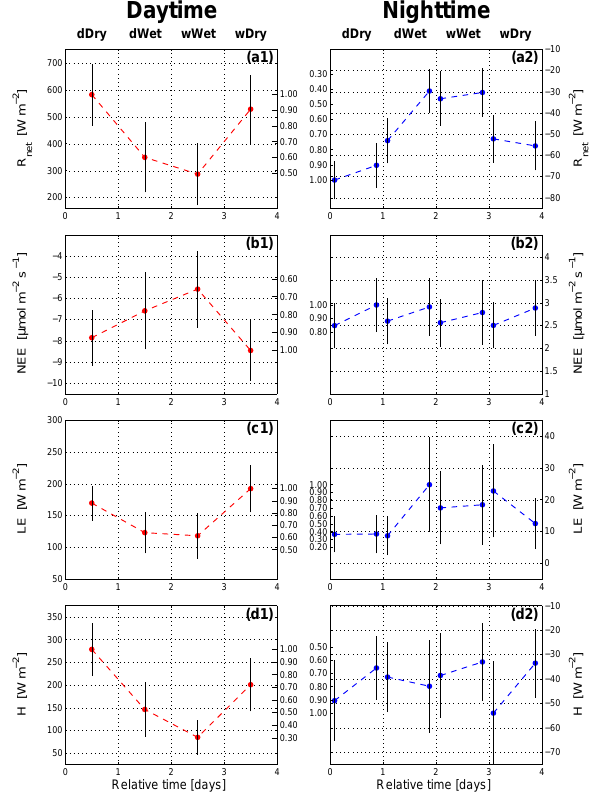
Figure 10. Mean values for (left column) daytime (10:00– 14:00MST) and (right column) night (00:00–04:00MST) and evening (19:00–23:00MST) periods of (a1, a2) net radiation R net ; (b1, b2) net ecosystem exchange of CO 2 NEE; (c1, c2) latent heat flux LE; and (d1, d2) sensible heat flux H . The values are arranged from left-to-right in the order of dDry, dWet, wWet, and wDry con- ditions. The vertical black lines represent the mean absolute de- viation (MAD) of the 30min data within that particular category and time period. The numerical values shown between the daytime and nighttime panels represent the fractional change relative to the largest (or smallest) data value within the panel. ↓ ) TOA SW tion of the magnitude of R net on wet nights was primarily due to changes in cloud cover as well as changes to the turbulent fluxes. Sensible heat flux during mid-day had a similar pattern to net radiation, with a large decrease in H (by ≈ 70 %) between dDry and wWet conditions, followed by a return toward dDry H on wDry days (Fig. 10d1). In contrast, la- tent heat flux followed a different pattern – the largest mean mid-day LE occurred on a wDry day with a value of around 200 Wm − 2 , which was around 15 % larger than mid-day LE on dDry days (Figs. 9c, 10c1). The extra energy used by LE (coupled with slightly lower R net values on wDry days) ex- plains why mid-day H only recovered to within 80 Wm − 2 (or 30 %) of dDry H as dictated by the SEB (Eq. 1) and shown in Fig.